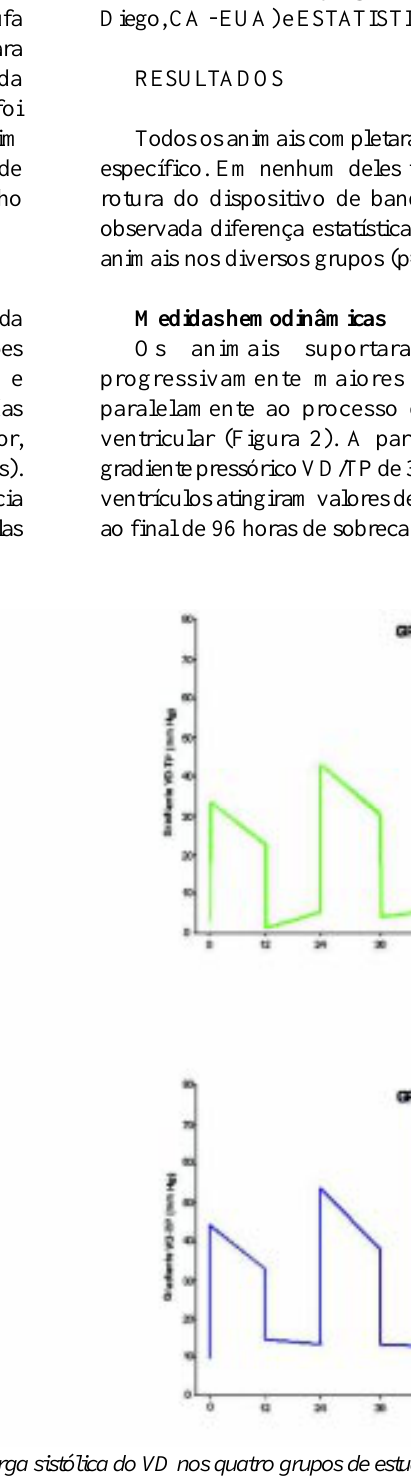
Fig. 2 - Diagrama demonstrativo da intermitência da sobrecarga sistólica do VD nos quatro grupos de